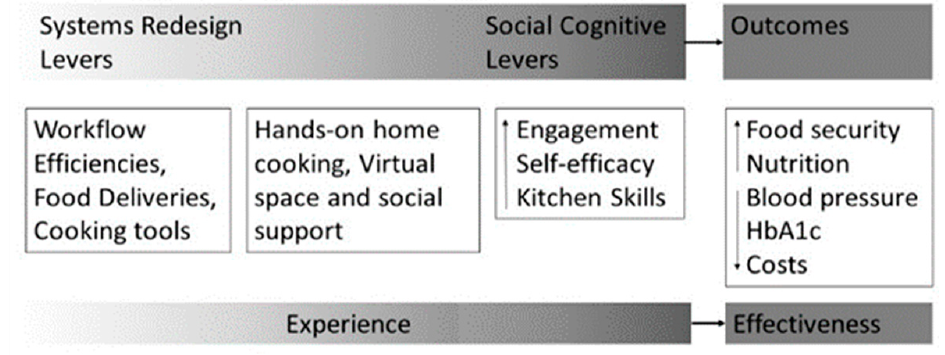
Figure 1. The system, experiential, and social levers, and outcomes.